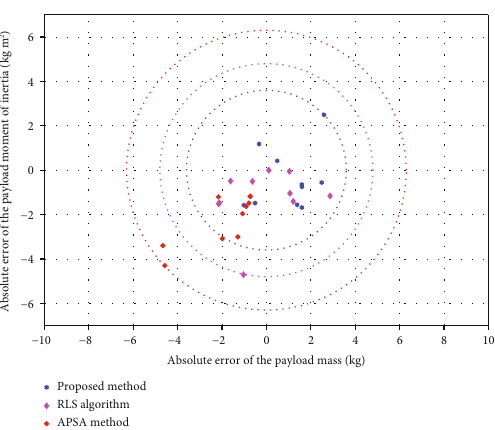
Figure 9: Absolute error (AE) of the payload parameters ̂ m (10 simulations for each